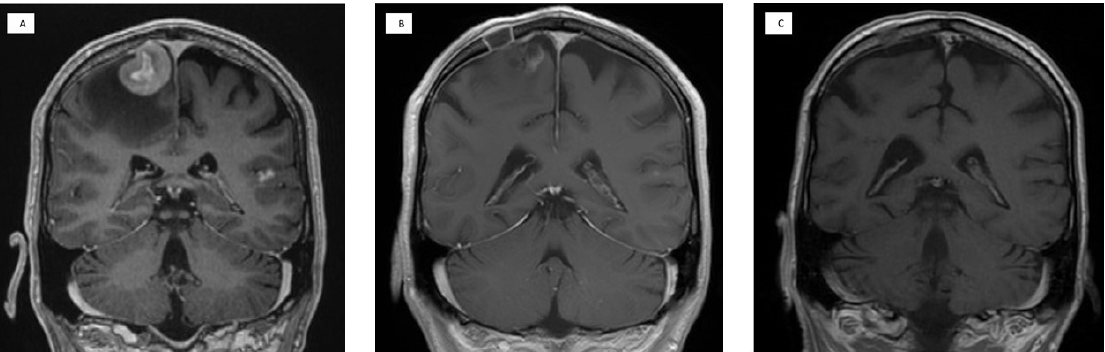
Figure 1. A demonstrative example of radiographic response to MATRix induction and BBBD therapy. A 64-year-old male had progressive weakness of left extremities. ( A ) Coronal contrast enhancer T1-weighted MRI revealed a hypervascular tumor in the right frontal lobe with surrounding oedema. Another hypervascular tumor was detected in the left temporal lobe. The PCNSL diagnosis was confirmed by biopsy. ( B ) Follow-up MRI after the MATRix induction showed significant debulking of both tumors. ( C ) After 4 BBBD cycles, both tumors had completely disappeared in MRI.